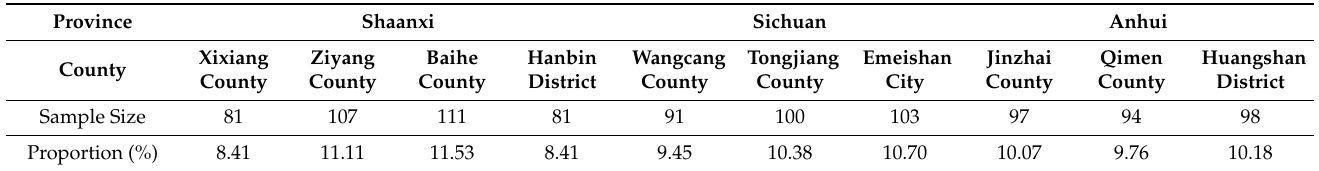
Table 1. Survey Area and Distribution of Sample Farmers.